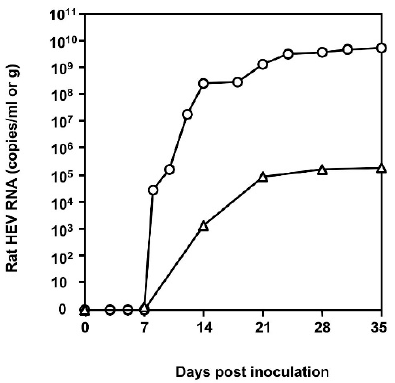
Figure 1. Kinetics of rat hepatitis E virus (HEV) RNA in the nude rat. A nude rat was inoculated with